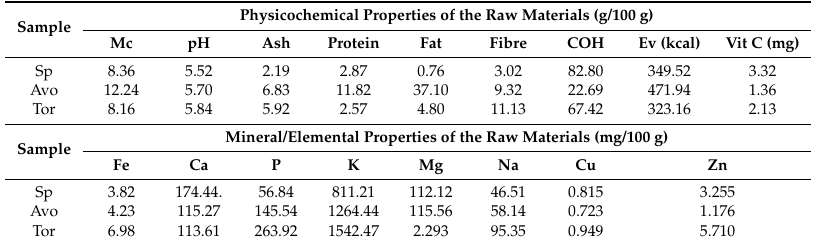
Table 2. Proximate, mineral, Vitamin C, pH, and Energy value of the composite flour.